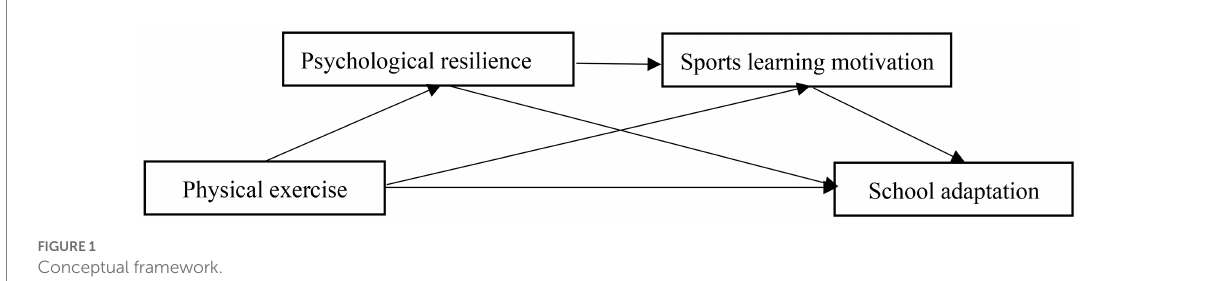
FIGURE 1 Conceptual